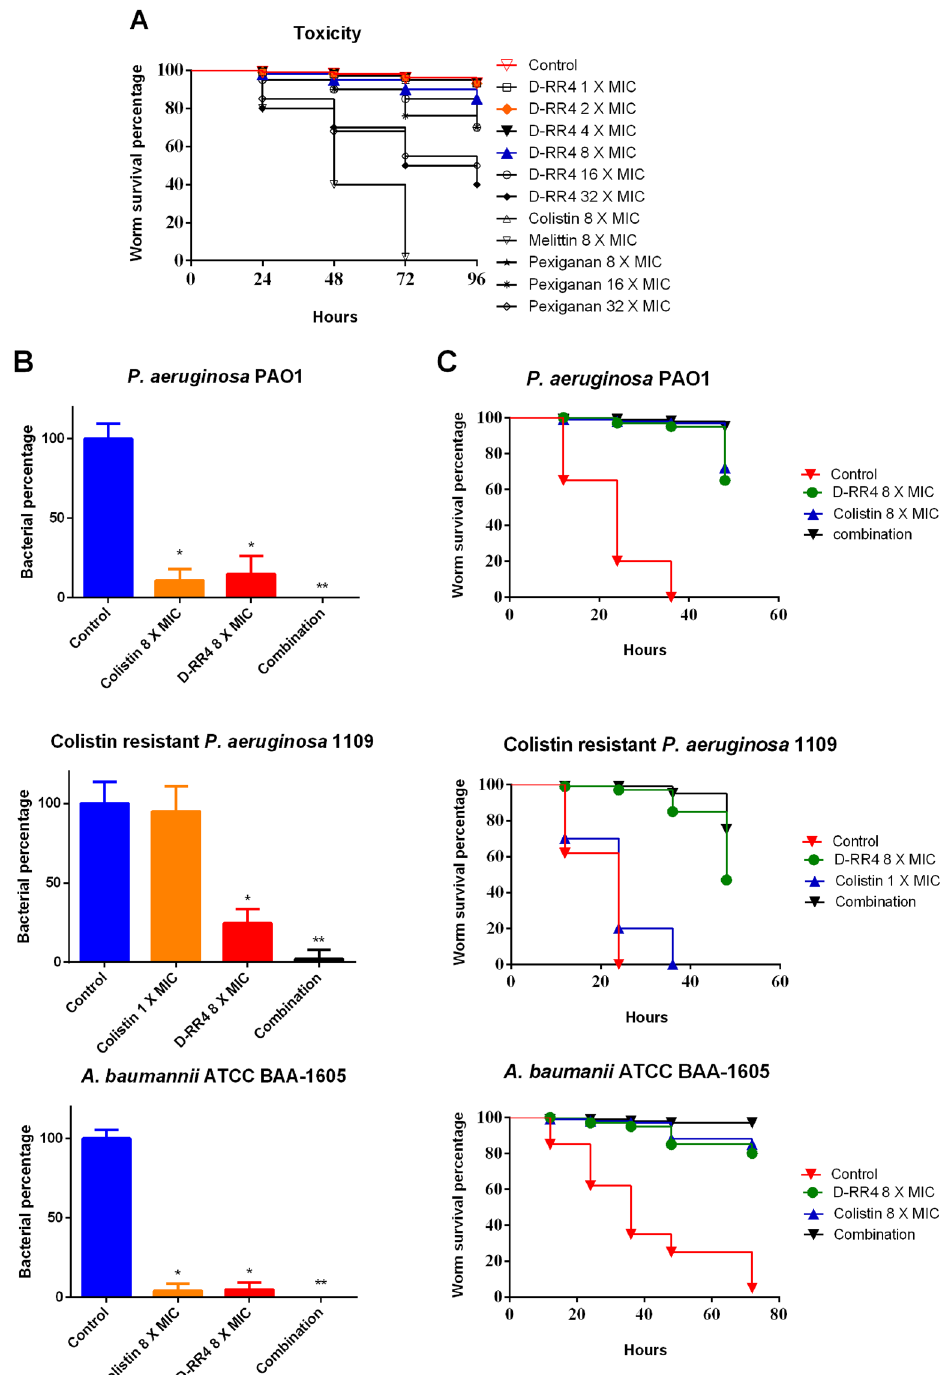
Figure 4. Antibacterial activity of D-RR4 and colistin in C. elegans models of bacterial infection. ( A ) Evaluation of toxicity of peptides in Caenorhabditis elegans . C. elegans strain glp-4;sek 1 was grown for four days in the presence of peptides at different concentrations. Worms were monitored daily and the live worms were counted. Results are expressed as a Kaplan-Meier survival curve. ( B ) Evaluation of antimicrobial activity of peptides to reduce the bacterial CFU inside infected Caenorhabditis elegans . C. elegans strain glp-4; sek 1 were infected with P. aeruginosa PAO1, colistin-resistant P. aeruginosa 1109, or A. baumannii ATCC BAA-1605. After infection, worms were treated with D-RR4 (at 8 × MIC), colistin (at 8 × MIC for all strains except colistin-resistant P. aeruginosa 1109 (tested at 1 × MIC)), or a combination of both agents. After treatment, worms were lysed and bacteria were counted. One asterisk ( * ) indicates significant difference with the negative control. Two asterisks ( ** ) indicates significant difference with the monotherapy treatment ( P < 0.05). Results are expressed as means from three biological replicates ± standard deviation. ( C ) Efficacy of peptides in a Caenorhabditis elegans model of bacterial infection. C. elegans strain glp-4; sek 1 were infected with P. aeruginosa PAO1, colistin